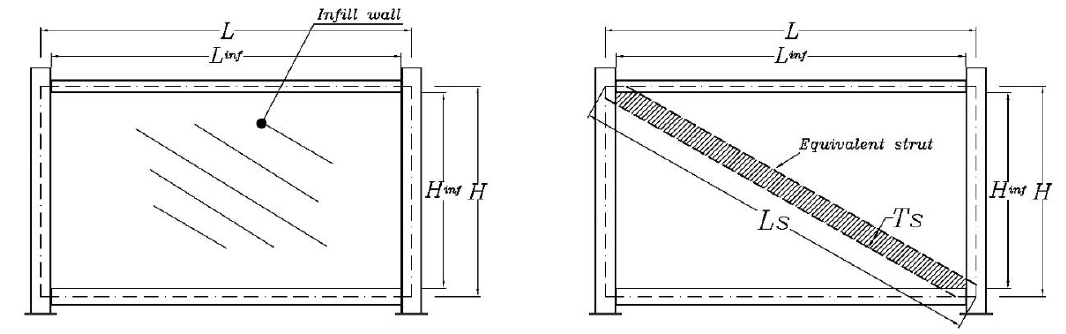
Figure 14. Schematic view of a general strut model for infilled modular frames.